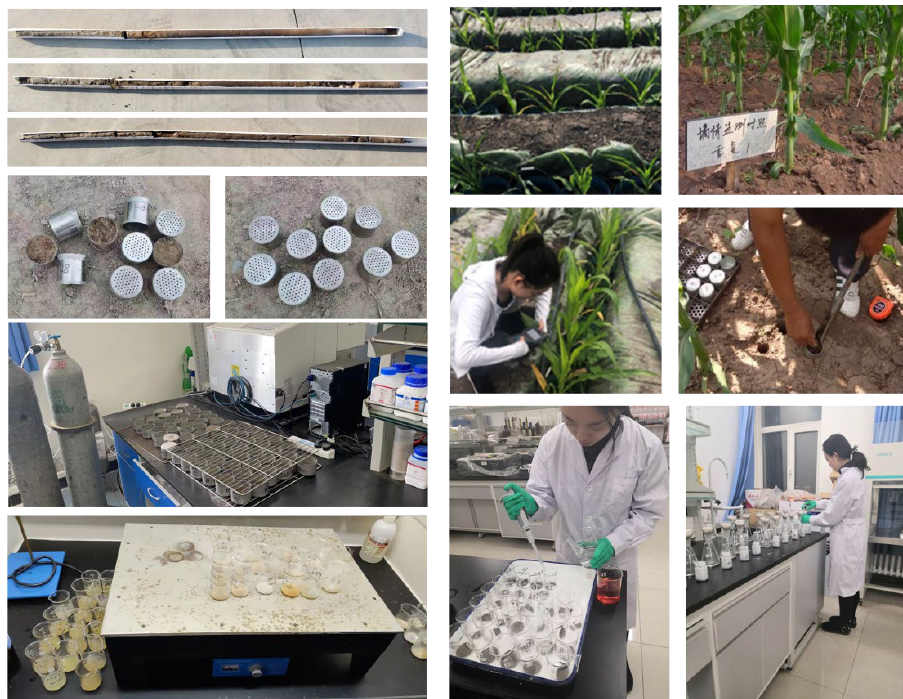
Figure 3. Soil parameter determination test.